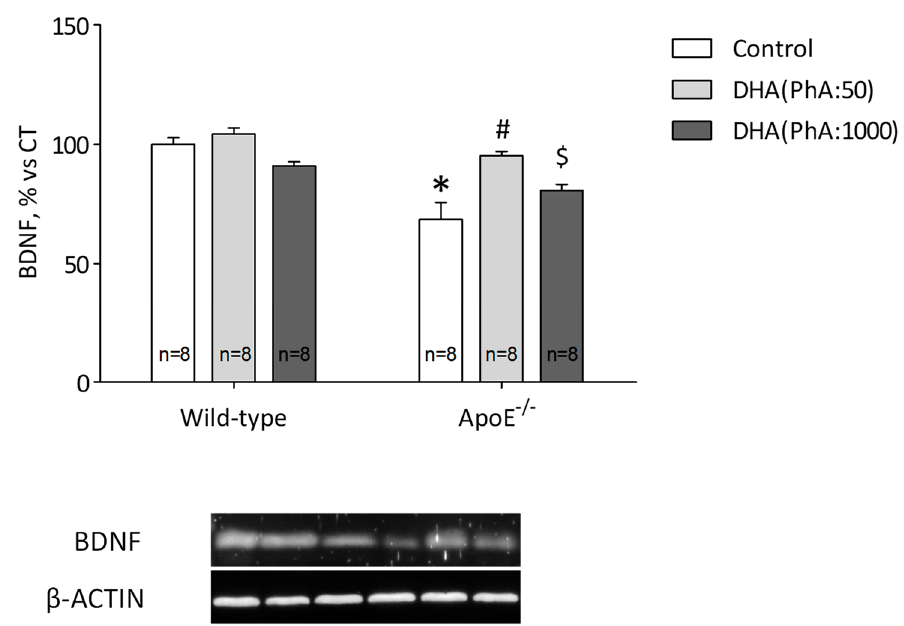
Figure 3. Effects of DHA (PhA:50) and DHA (PhA:1000) on relative protein expression of ( A ) amyloid precursor protein (APP) and ( B ) amyloid beta (Aß) in hippocampus of ApoE − / − and wild-type mice. Data show mean ± SEM. * p < 0.05 compared to control wild-type mice; # p < 0.05 compared to control ApoE − / − mice; $ p < 0.05 compared between DHA (PhA:50) and DHA (PhA:1000) in ApoE − / − mice. ( n = 8).